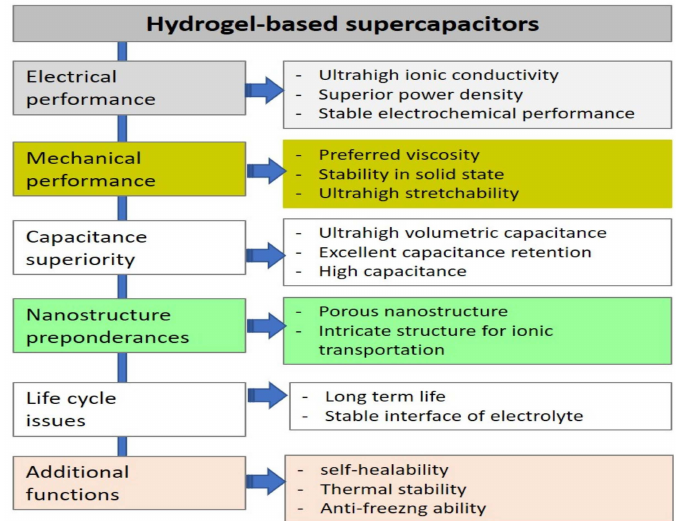
Figure 4. Reasons why hydrogel-based supercapacitors are preferred. Re-produced with permission with Under a Creative Commons (CC-BY) license 4.0 with Ref.